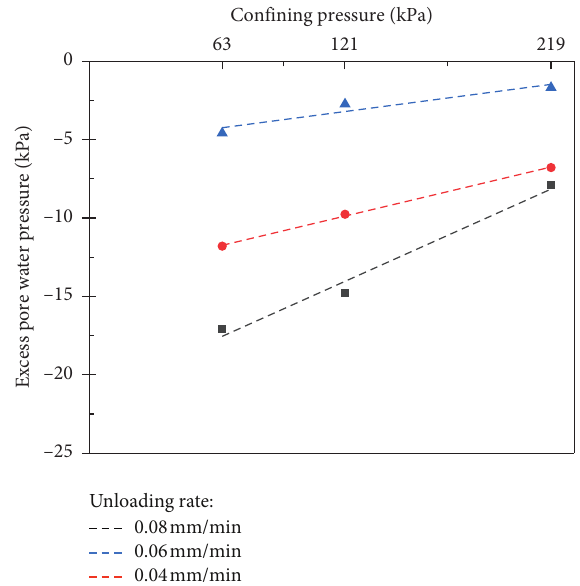
Figure 12: Curves of peak value of excess pore water pressure with confining